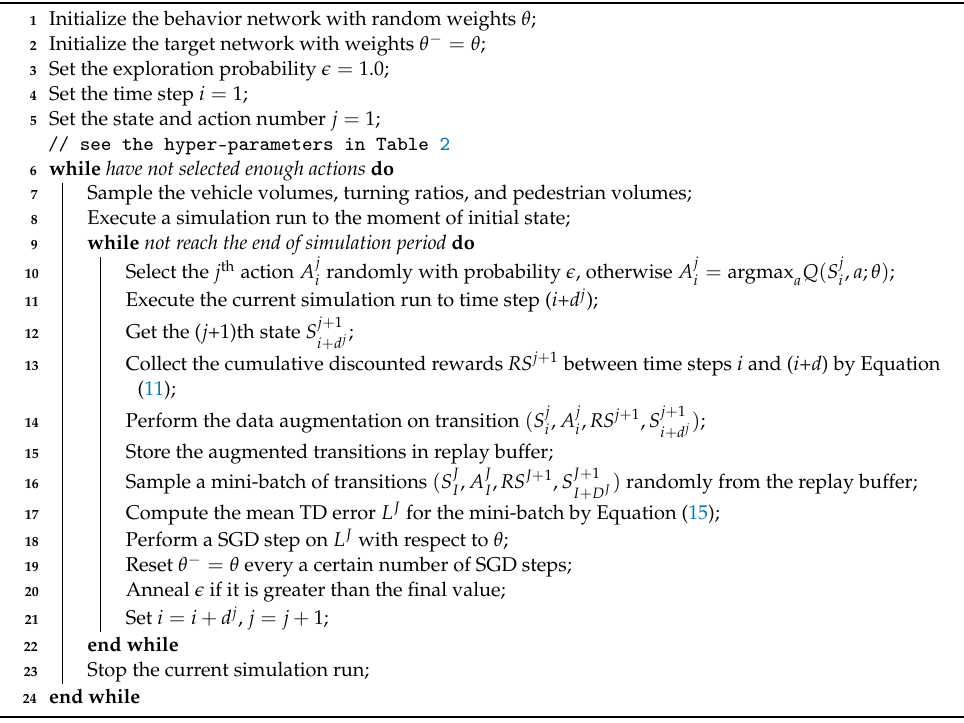
Algorithm 1: Training process of D3ynQN